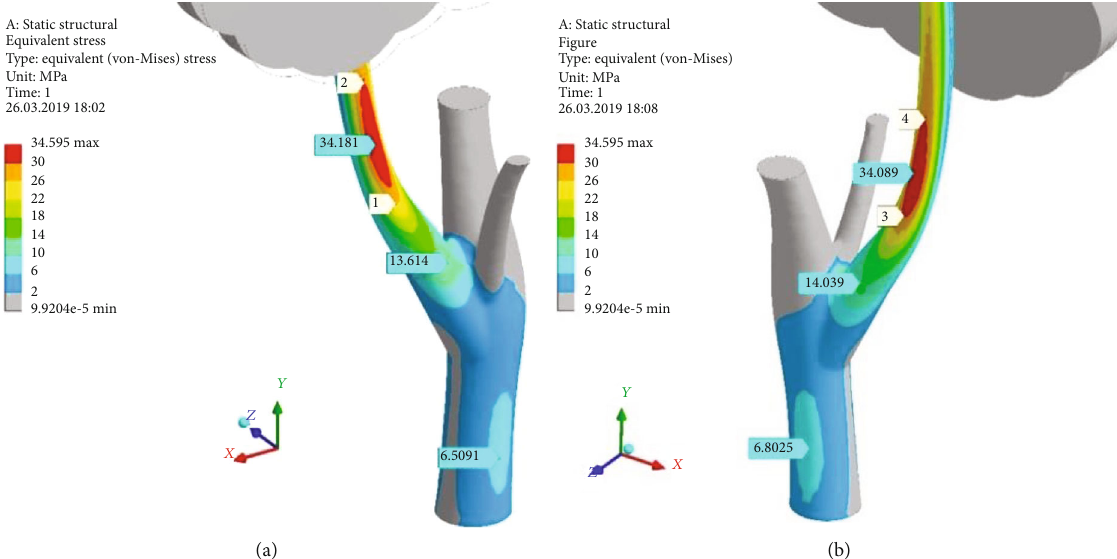
Figure 10: Distribution of the equivalent stress ( σ e ) (MPa) through the surfaces of the branch and trunk on the windward (a) and leeward (b) sides. Pressure ð p wind norm Þ = 380 Pa; RectCrown, ×